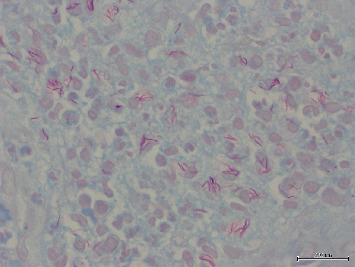
Acid-fast bacilli by EZN, ×1000.